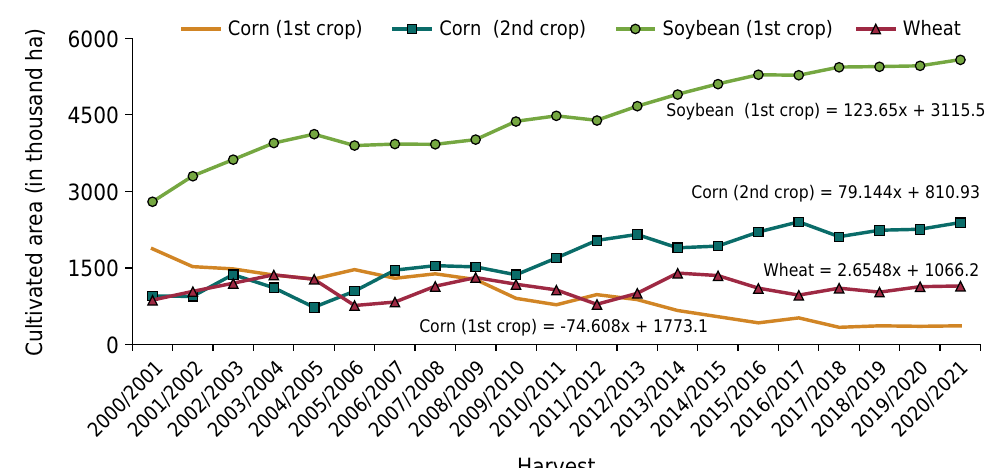
Figure 2. Evolution of the cultivated area (in thousand hectares) with the main annual crops in Paraná State between agricultural years 2000/2001 and 2020/2021 in the different annual crops. Source: Paraná